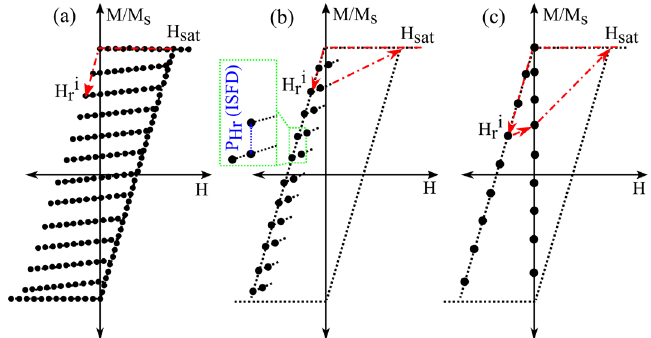
Figure 2. Schematic comparison of conventional FORC and alternative methods with necessary data (black dots). The red dashed lines show the direction of the field change. ( a ) Conventional FORC typically measures ~ 100 data points for each reversal curve, ( b ) ISFD requires only two data points on each reversal curve (as shown), and ( c ) BRM measures magnetization at zero field after the application of each H r